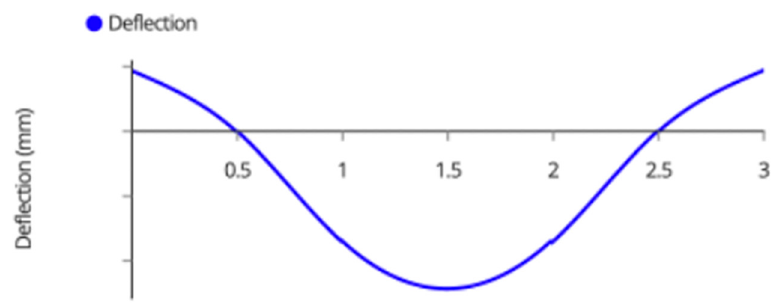
Figure A8. Beam deflection diagram.